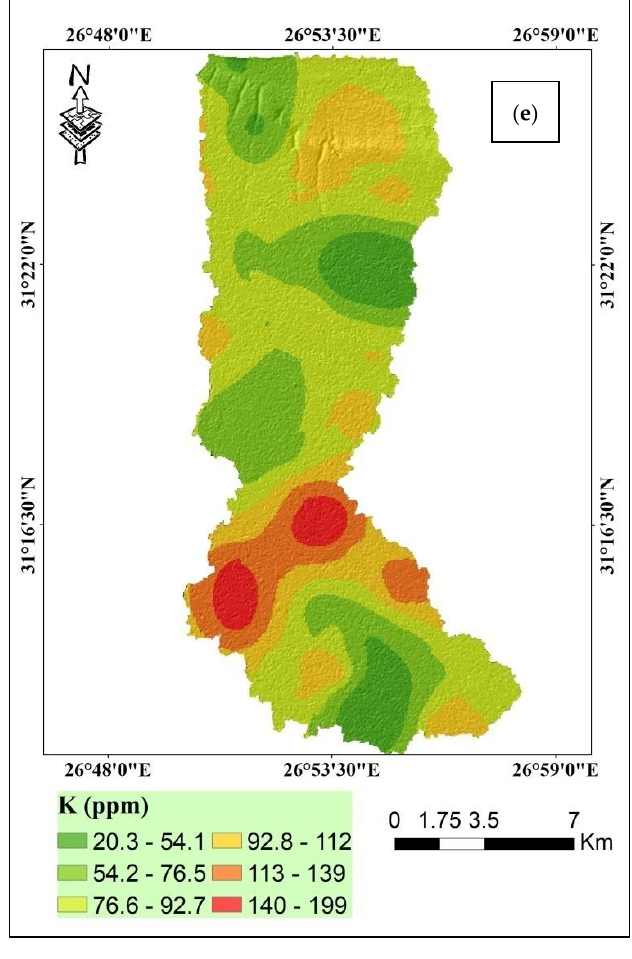
Figure 9. Spatial distribution of measured SOC parameters: ( a ) pH, ( b ) soil organic matter %, ( c ) nitrogen content (ppm), ( d ) phosphorus content (ppm), and ( e ) potassium content (ppm). Table 3. Statistics of measured SFC parameters.